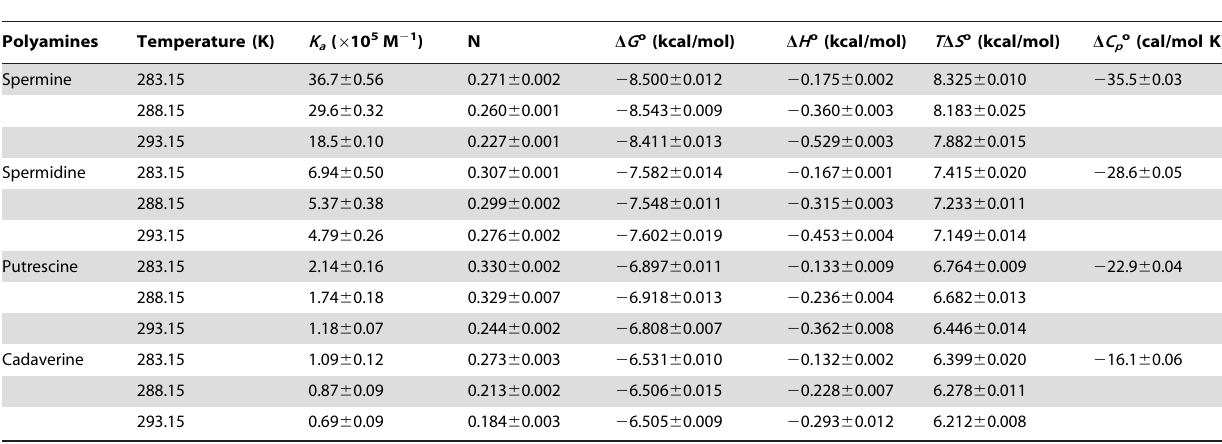
Table 1. ITC derived thermodynamic parameters for the binding of polyamines to CP DNA a .